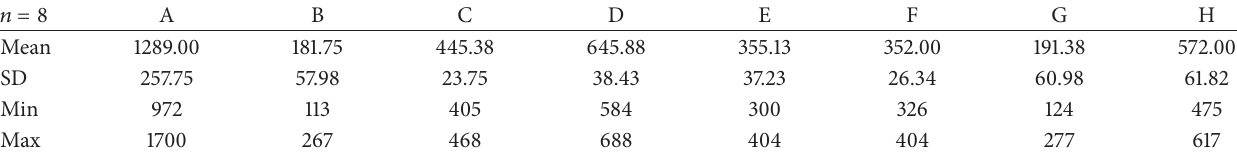
Table 1: The comparison of the average values for resistance between the groups.